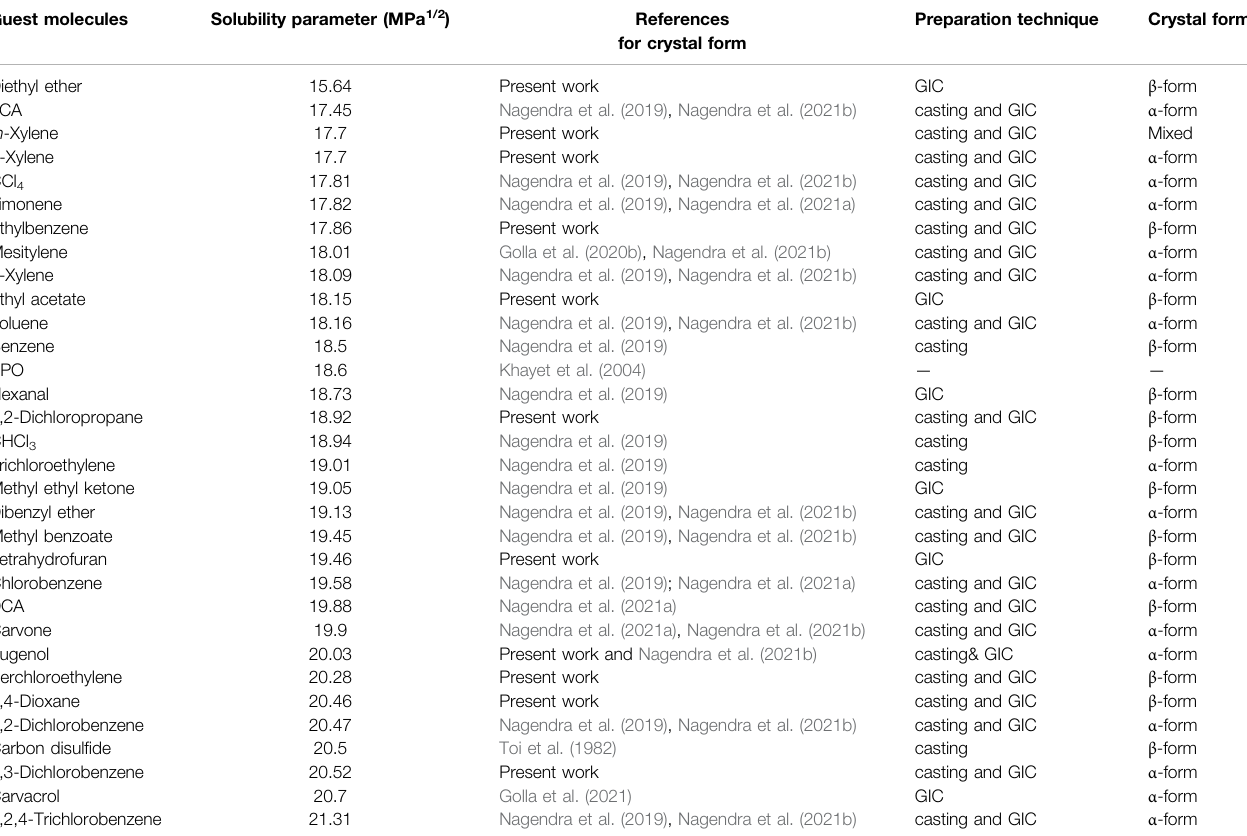
TABLE 1 | Solubility parameter of the guest molecules vs the corresponding crystalline phases of PPO. (For the sake of comparison, the solubility parameter of PPO is also included.) Guest molecules Solubility parameter (MPa 1/2